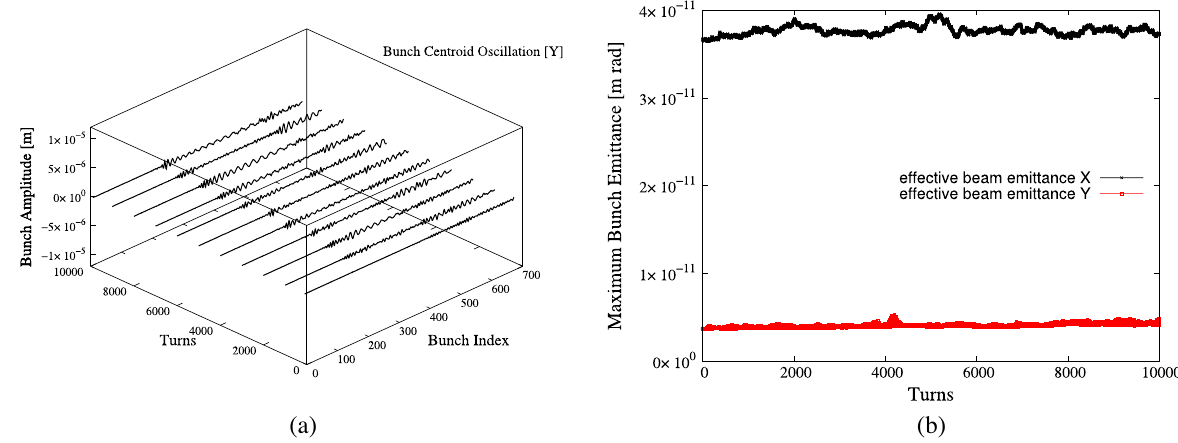
FIG. 13. Beam bunch oscillations (left) and the effective rms emittance (right) as functions of the passing turns; both the synchrotron radiation damping and bunch-by-bunch FIR feedback system are taken into account. The results are obtained from the quasi-strong- strong